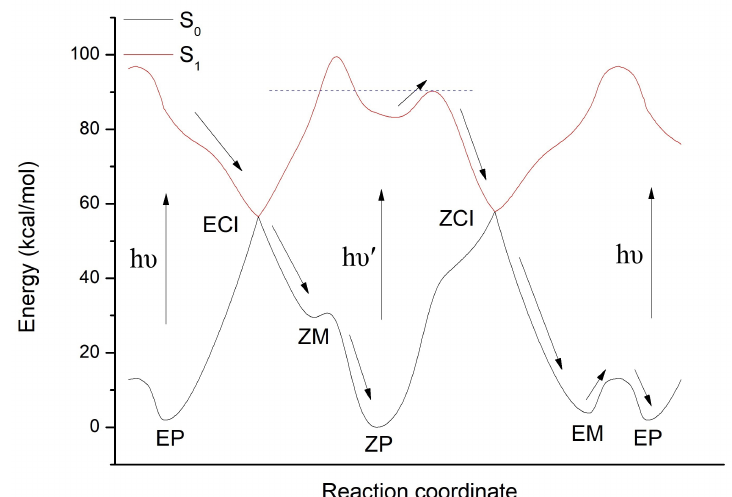
Figure 7. OM2/MRCI energy profiles of the S 0 and S 1 state generated by the linear interpolation among EP , ECI , ZM , ZP , ZCI , and EM structures of DDIY. The relative energies are calculated with respect to the ground state ZP conformation. The black arrows indicate the reaction